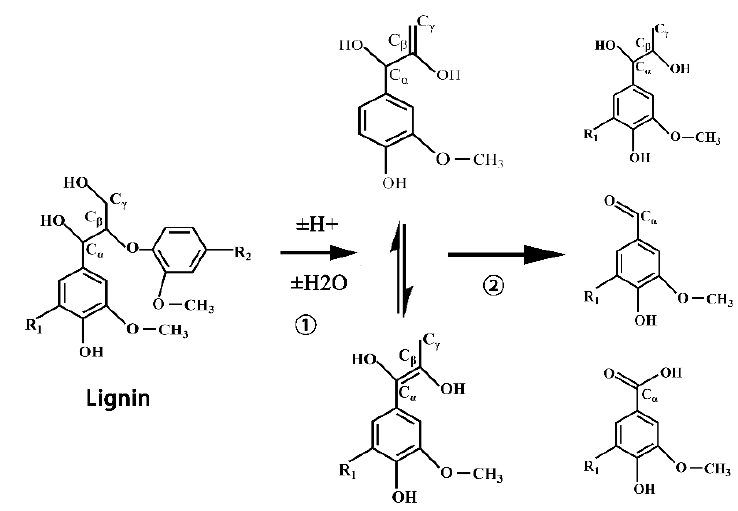
Figure 2. The degradation reaction ( ① ) and polycondensation ( ② ) of lignin.